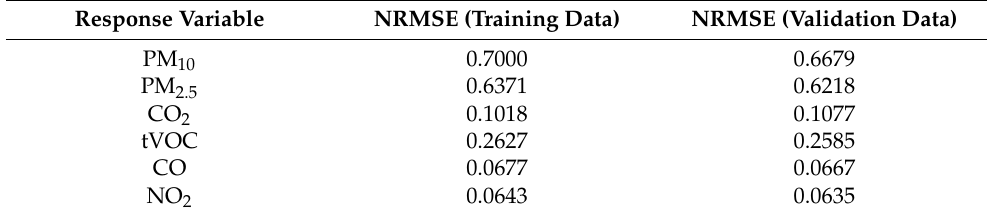
Table 5. ADFIST performance evaluation on training and validation